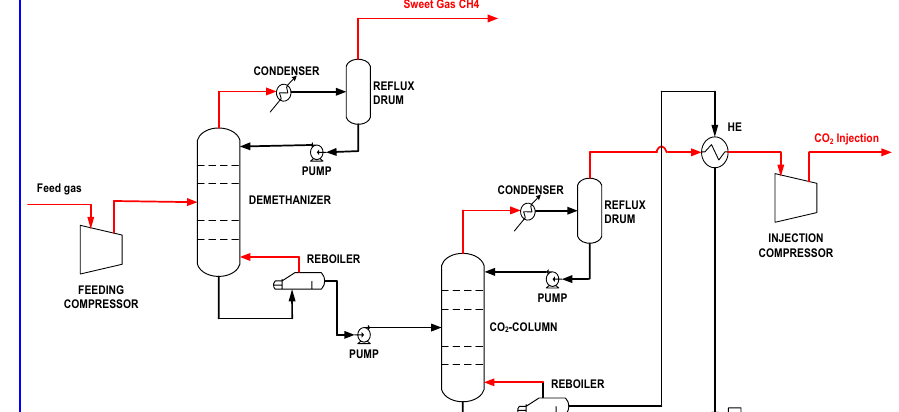
Fig. 6 PFD of cryogenic distil- lation